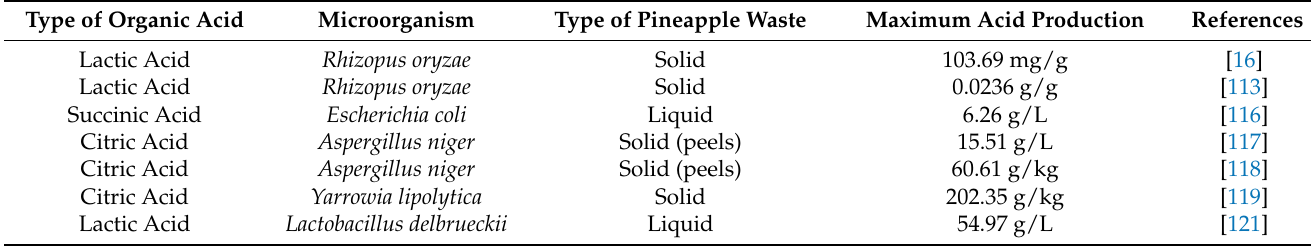
Table 2. Organic acid production from pineapple